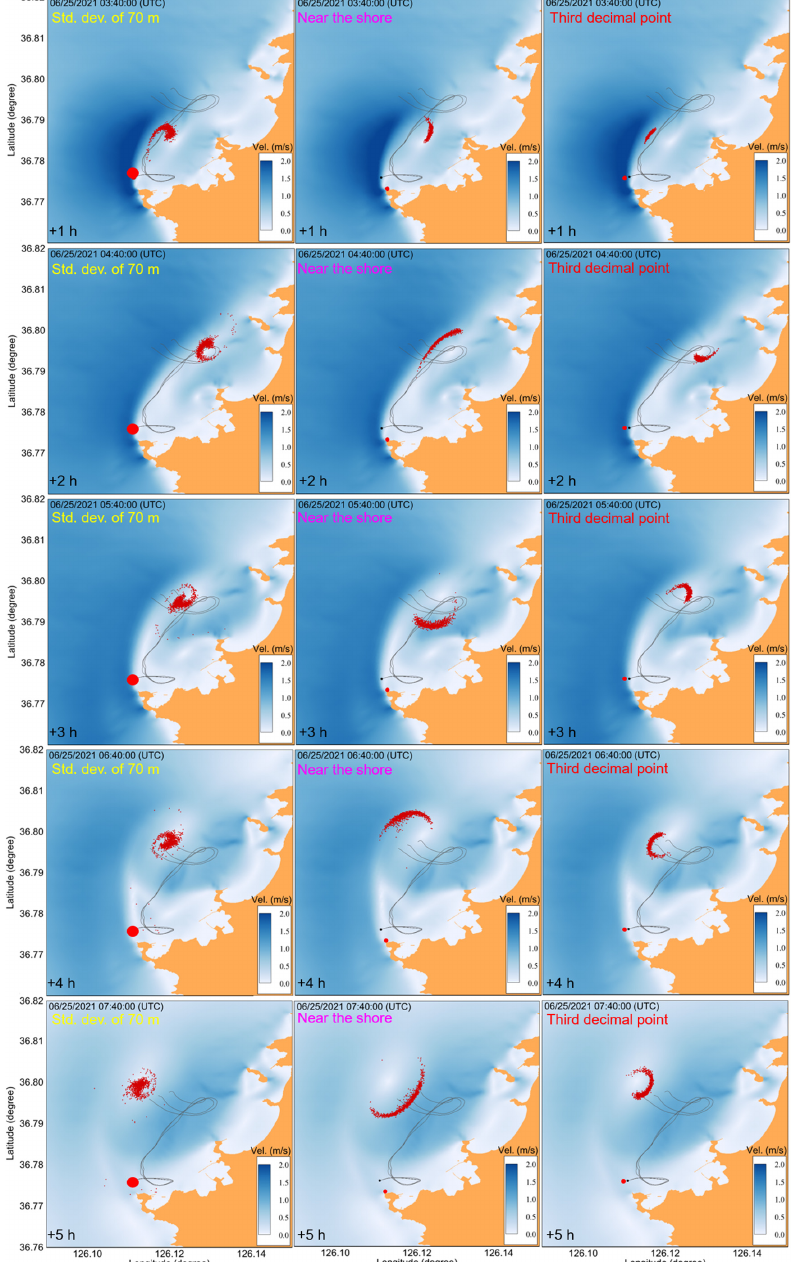
Figure 13. Simulated results depending on the source location of particle release after every hour 1 of floating up to 5 h, overlapped on the black solid line of actual tracks ( left-panel ) shifted as a standard deviation of 70 m ( mid-panel ), intentionally locating near the shore, and ( right-panel ) input of uncertain coordinate as third decimal point